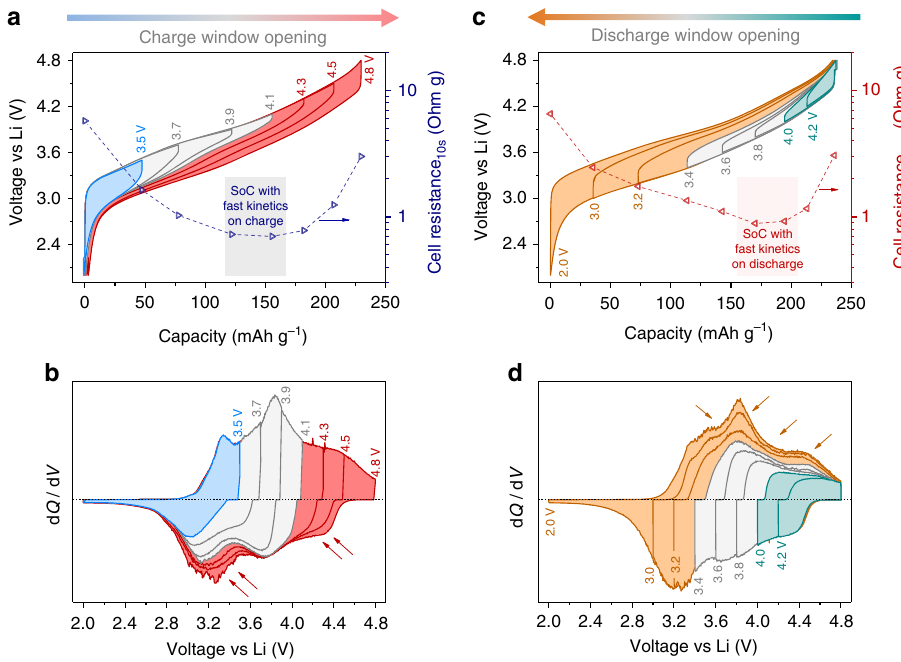
Fig. 4 Hysteresis and path dependence in activated LR-NMC studied by voltage window opening. a Voltage pro fi les and b corresponding d Q /d V curves as the charge window is opened stepwise from 2.0 to 4.8 V. LR-NMC is fi rst activated by a few formation cycles in 2.0 to 4.8 V. All curves in a and b start on the charge direction from 2.0 V (at 0 mAh g − 1 ) and trace identical charging paths, whereas the discharges vary with cutoff voltages. Different regimes are highlighted with different colors. Hysteresis is triggered above 4.1 V as the capacity expected from high-potential charge (4.1 – 4.8 V, red) is split on discharge between high and low potentials, as marked by arrows in b . At each cutoff, the cell ’ s resistance (right axis in a ) is also estimated by Ohm ’ s law applied to the voltage relaxation during a 10 s rest-step applied when switching from charge to discharge. Current density is 40 mA g − 1 . The SoC is highlighted, where resistance minimizes during charge. c Voltage pro fi les and d corresponding d Q /d V curves as the discharge window is opened stepwise from 4.8 to 2.0 V, in a fashion opposite the fi rst experiment. All curves in c and d start on the discharge direction from 4.8 V (fully charged initially). The capacity expected from low potential discharge (3.4 – 2.0 V, orange) is spread from low to high potentials on charge, as marked by arrows in d . The cell resistance (right axis in c ) is estimated from the voltage relaxation during a 10 s rest-step applied when switching from discharge to charge. The SoC with cell resistance minimum on discharge path is